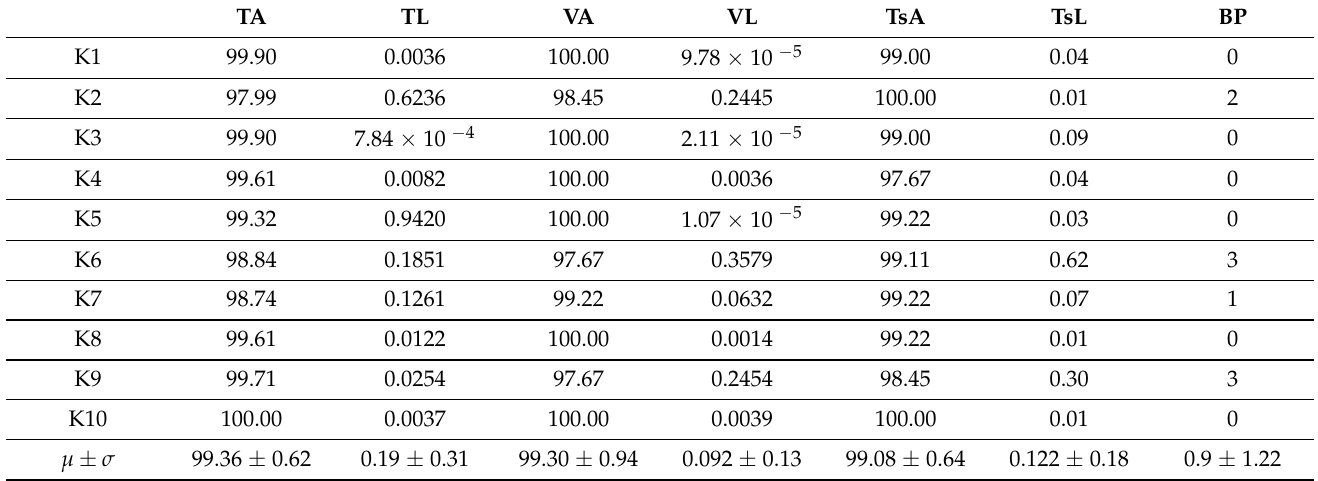
Figure 3. Train and validation results of 10th fold from proposed DICNN. ( a ) Depicts 99.36 ± 0.62% training accuracy and 99.30 ± 0.94% validation accuracy. ( b ) Conveys 0.19 ± 0.31 of training loss and 0.092 ± 0.13 of validation loss. Table 2. TA, VA, TL, VL, TsA, TsL, and BD for the DICCN model, standing for training accuracy, training loss, validation accuracy, validation loss, test accuracy, test loss, and the number of bad predictions from the model for K = 10-fold in